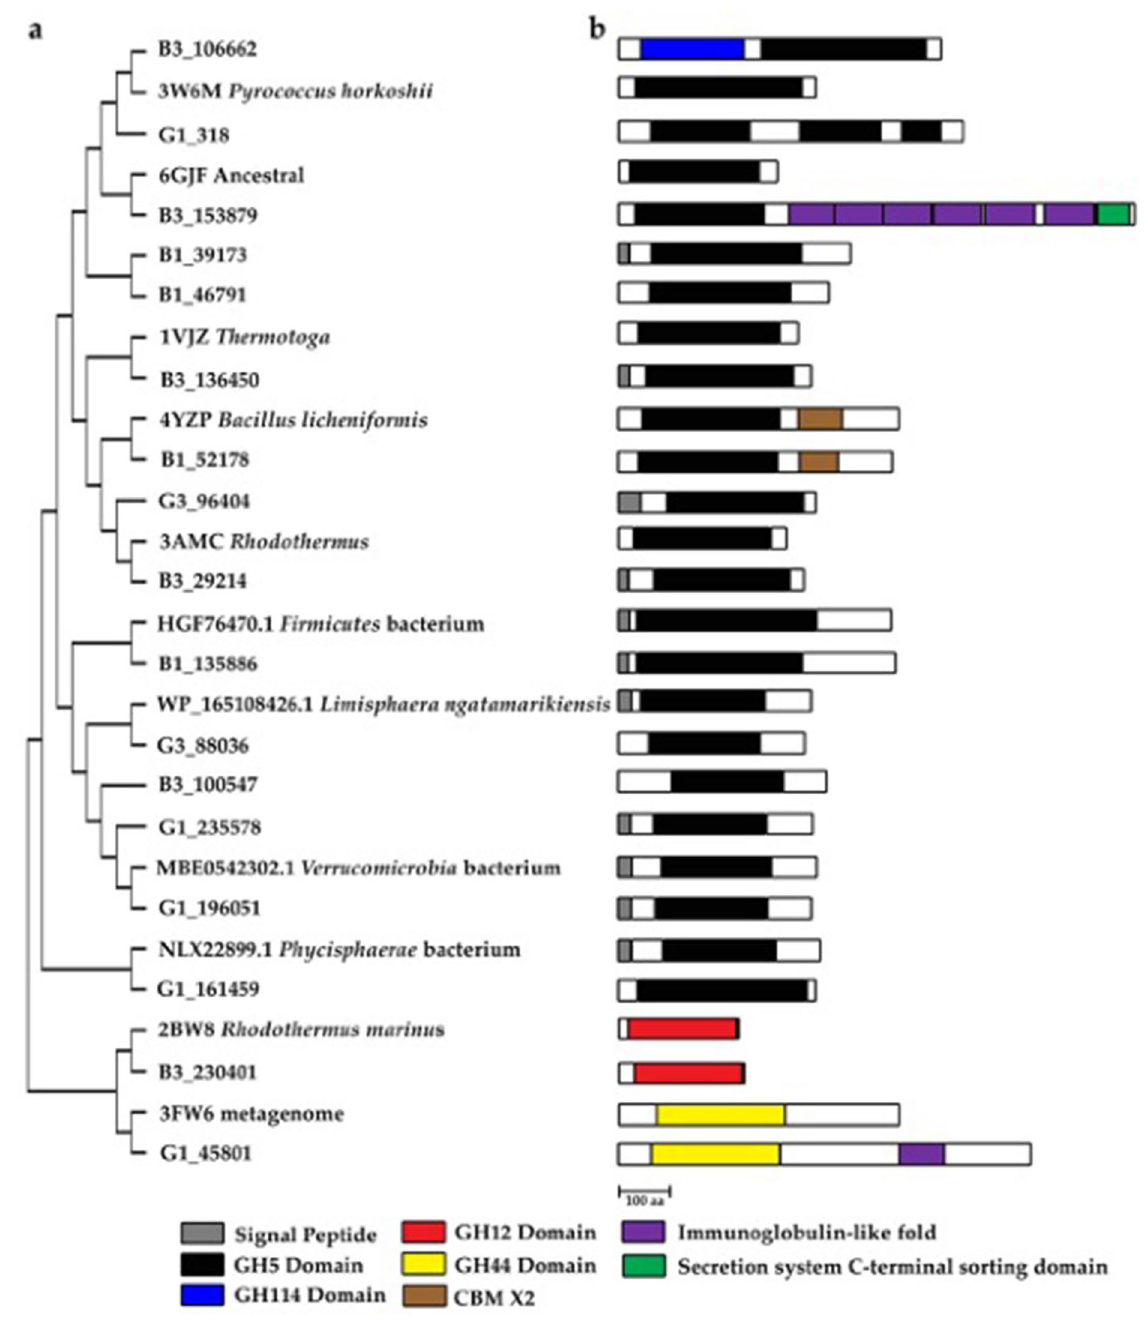
Figure 7. ( a ) Dendogram of GH5 cellulases. ( b ) Domains in